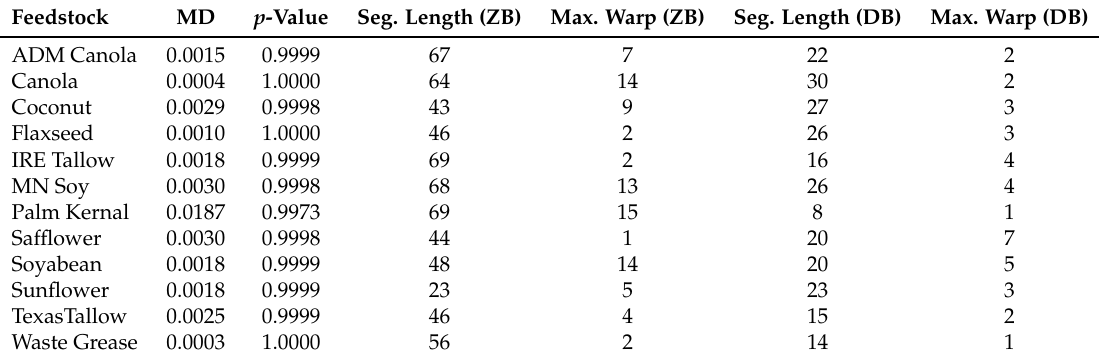
Table 2. MD, p -value, and optimal COW alignment parameters (segment length and maximum warp) for each feedstock, with alignment to a universal chromatogram chosen based on similarity index. The MD was computed based on L = 3 PCs.